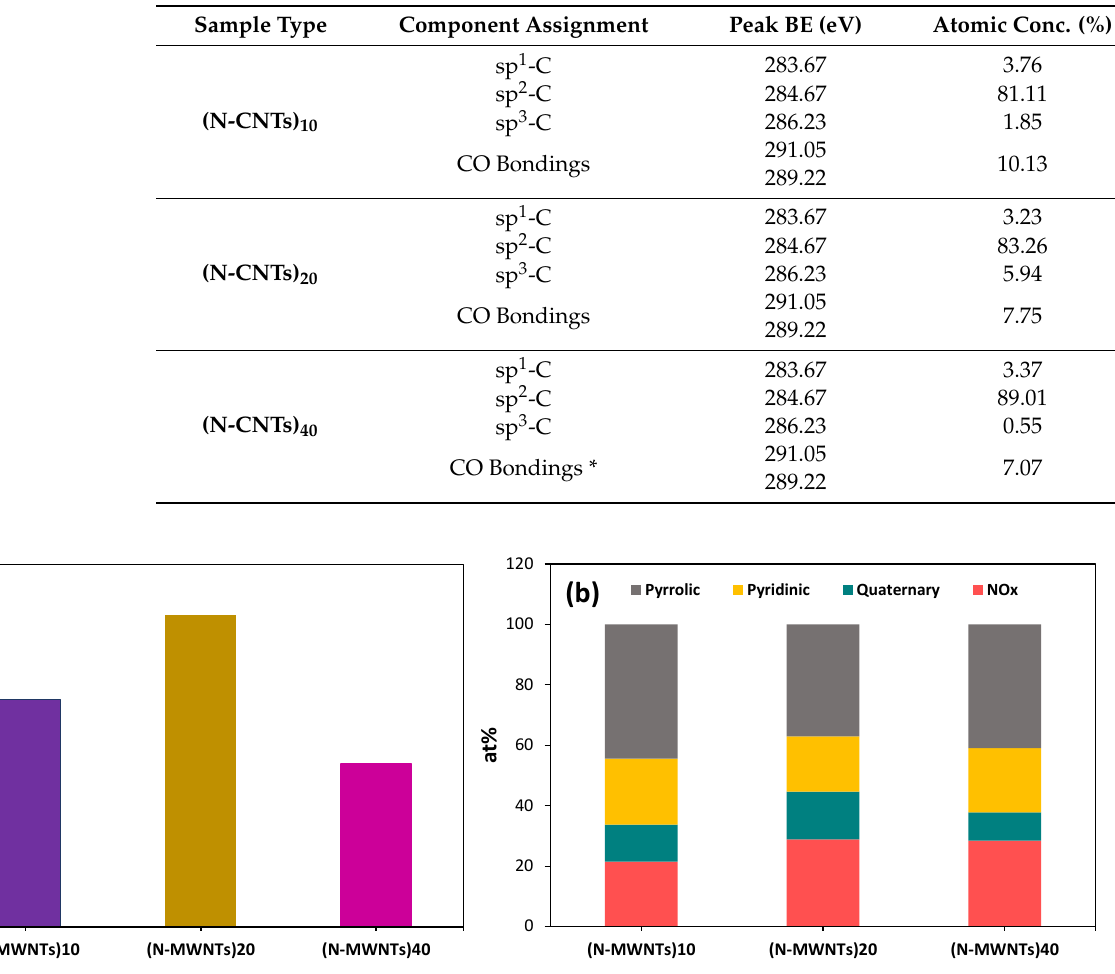
Figure 3. ( a ) Plot of nitrogen content in structure of N-MWNTs as a function of catalyst loadings to alumina support, ( b ) plot of the percentage of different types of nitrogen incorporation in N-MWNTs for different growth catalyst.